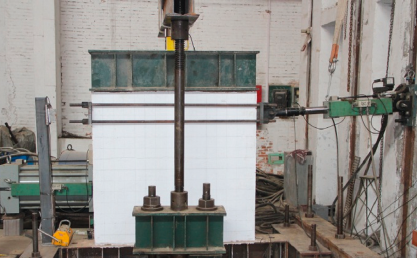
Figure 6: Measurement layout of instrumentation.